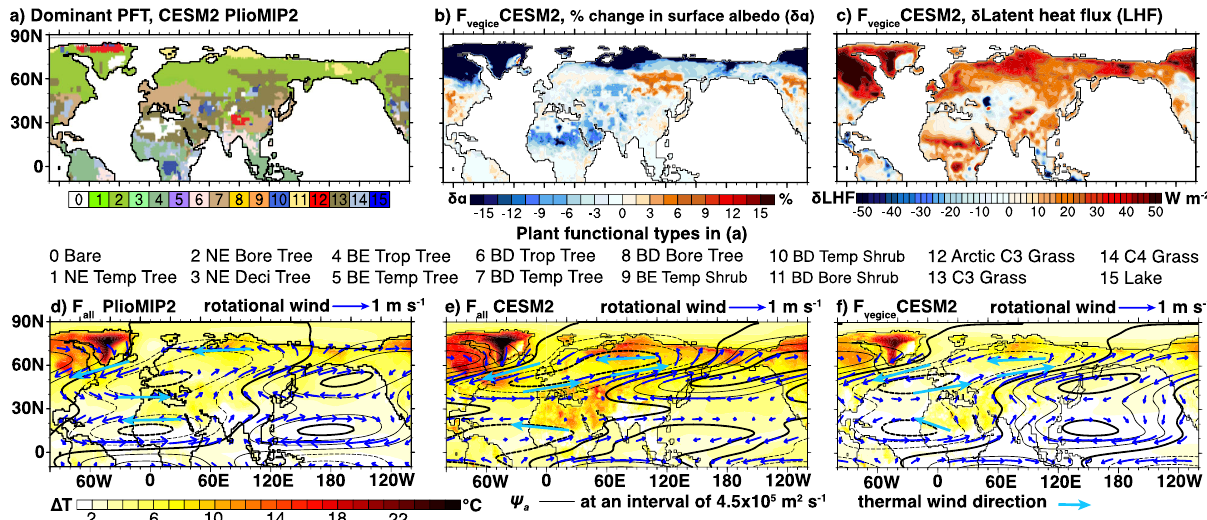
Fig. 3 Climate responses to the full mid-Pliocene climate forcing ( F all ) and forcing from vegetation and ice sheet changes ( F vegice ). a vegetation and ice sheet distribution: the plant functional type (PFT) with the highest percentage in a grid cell is shown. Changes of b surface albedo ( δα , %) and c surface upward latent heat fl ux ( δ LHF , W m − 2 ) induced by F vegice . Label abbreviations in a are, NE needleleaf evergreen, BE broadleaf evergreen, BD broadleaf deciduous, Temp temperate, Bore boreal, Deci deciduous, Trop tropical. d – f Simulated responses of surface temperature ( Δ T , °C) (color shaded), and wave number 1 of the 600 hPa stationary wave ( ψ a , contour, m 2 s − 1 ) and corresponding rotational winds (vectors, m s − 1 ) to d all forcings ( F all ) in the PlioMIP2 ensemble, e F all in CESM2, and f F vegice in CESM2. The diagnosed thermal wind directions based on the Δ T pattern are also